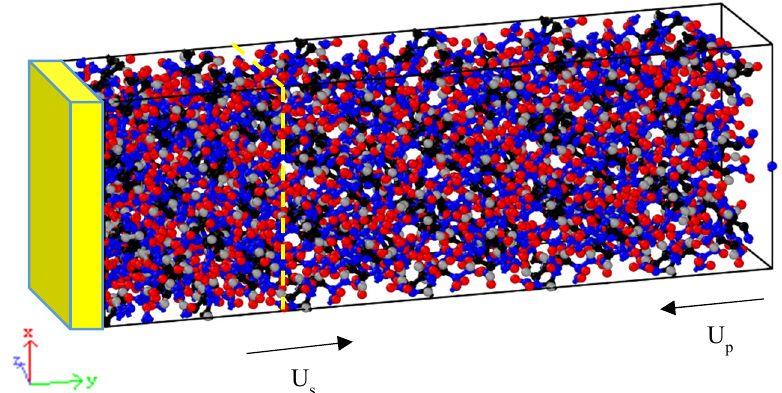
Figure 2. Schematic diagram of the shock-loading crystal calculation model (the left yellow region represents the reflection wall, Up represents the atomic directional velocity and Us represents the wave front propagation velocity). C, H, O, and N atoms are colored black, gray, red, and blue, respectively.